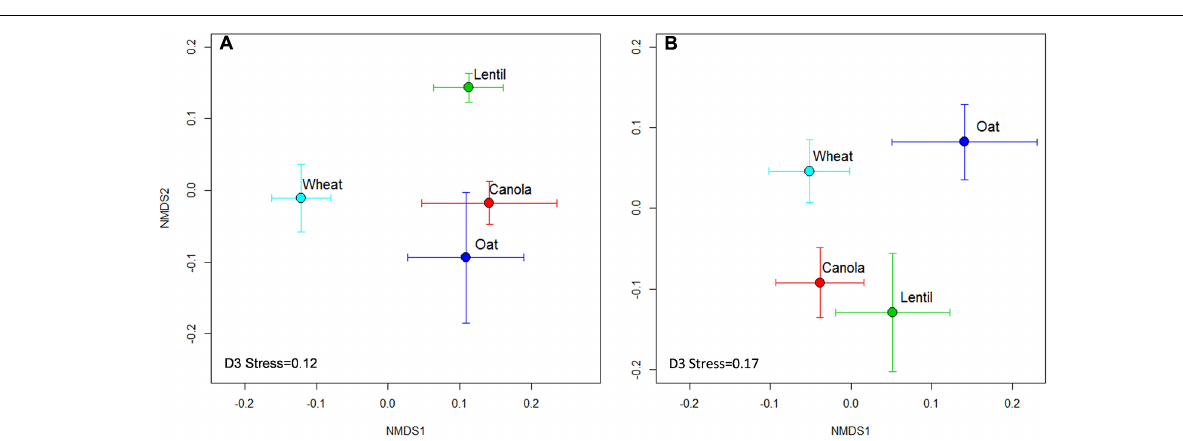
FIGURE 6 | Non-metric multidimensional scaling (NMDS) ordination of previous crops on rhizosphere fungal communities in 2015 (A) and 2016 (B) . Symbols indicate the mean axis coordinates ( ± SE) for each crop. A significant ( P < 0.001) year effect was observed for fungal community composition and thus the year 2015 and 2016 were presented